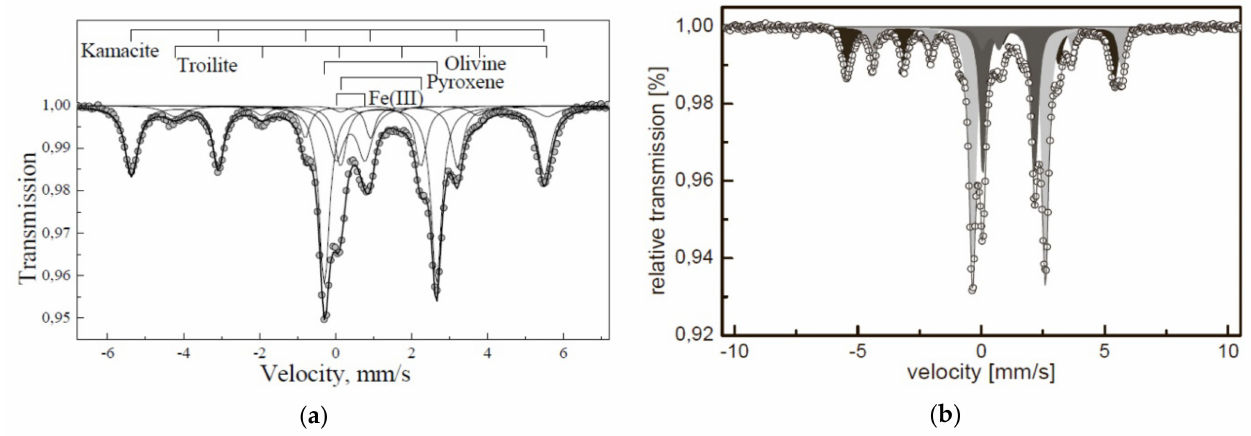
Figure 16. Room temperature Mössbauer spectra of equilibrated ordinary chondrites Pavel H5 ( a ) and Košice H5 ( b ). Indicated components are the results of the fits. Adapted from References